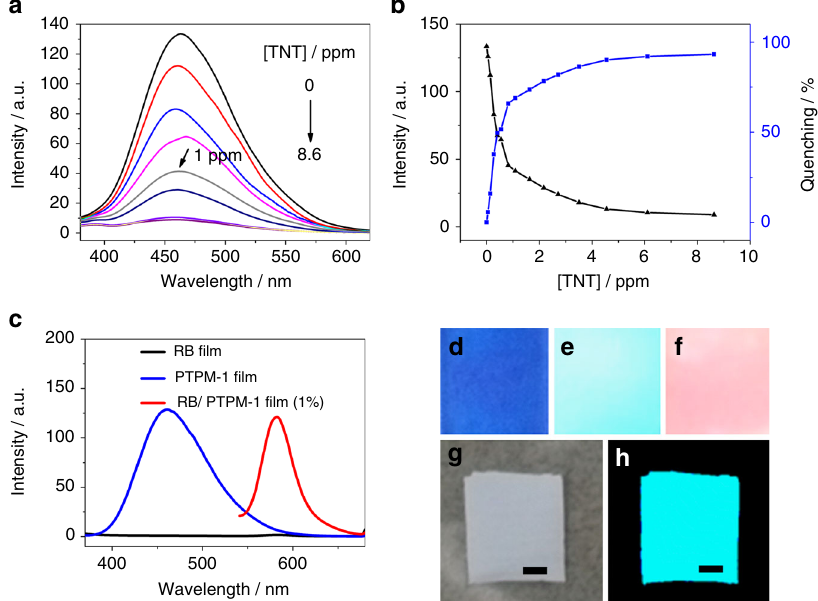
Fig. 5 Applications of PTPM-1. a Emission spectra and b intensities and quenching ratio of PTPM-1 solution (0.02 mg/mL in 90% of water/THF mixtures (vol%)) upon adding of TNT (excited @346 nm); c emission spectra of RB fi lm, PTPM-1 fi lm, and RB/PTPM-1 fi lm containing 1% (wt%) of RB (excited photos of PTPM-1 textiles via static electrospinning: g under sunlight and h under irradiation with UV lamp @365 nm. Scale bar is 2.5 mm for